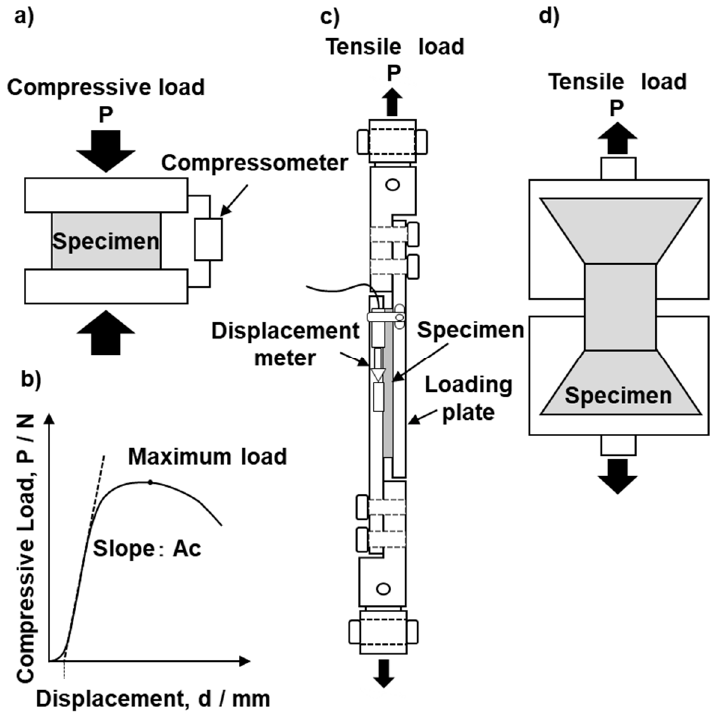
Figure 3. Schematic illustrations of ( a ) compressive test jig, ( b ) compressive load–displacement response, ( c ) tensile plate shear test setup, and ( d ) tensile test grip.